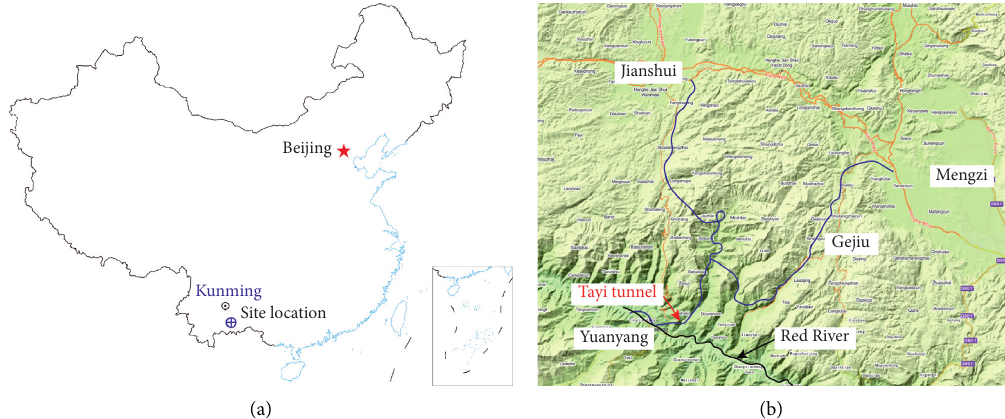
Figure 1: Site location (a) and layout plan (b) of the Jian-Ge-Yuan Highway Project. The site location is based on the standard map (no. GS(2019) 1684) by Ministry of Natural Resources of the People’s Republic of China. The layout plan is based on the online map by National Platform for Common Geospatial Information Services of the People’s Republic of